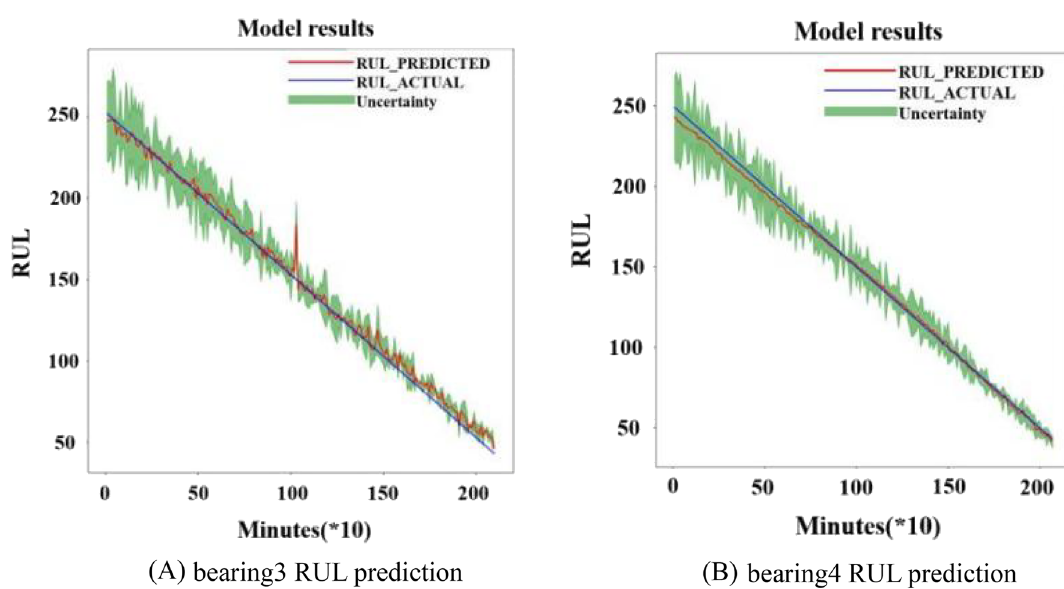
Figure 15. Test result with uncertainty in dataset 1; ( A ) bearing3; ( B )